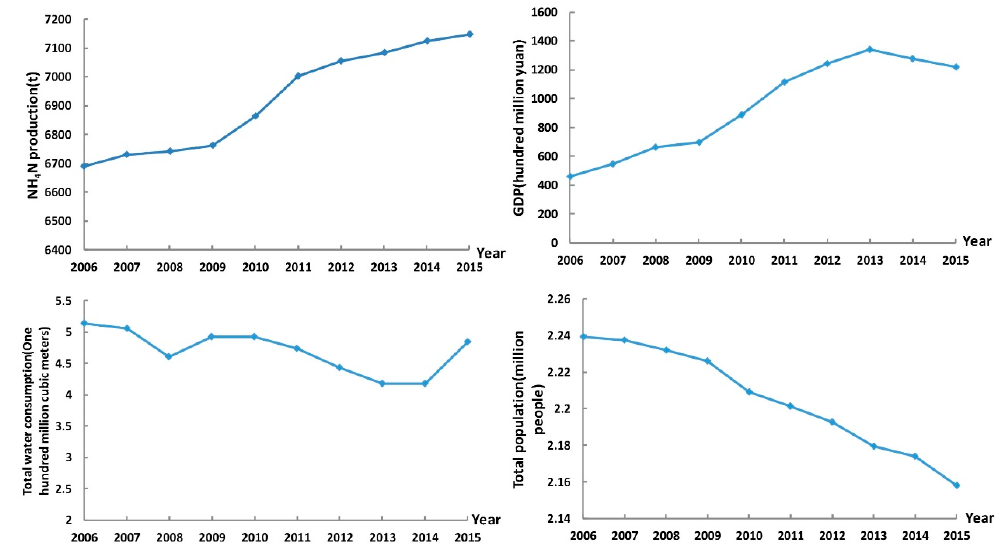
Figure 2. The change trend of total water consumption, NH 4 N production, total population and GDP from 2006 to 2015.